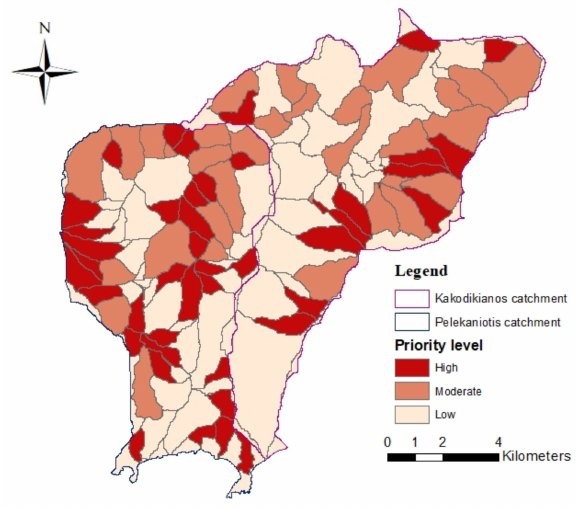
Figure 23. Priority levels of the sub-catchments based on morphometric parameters.